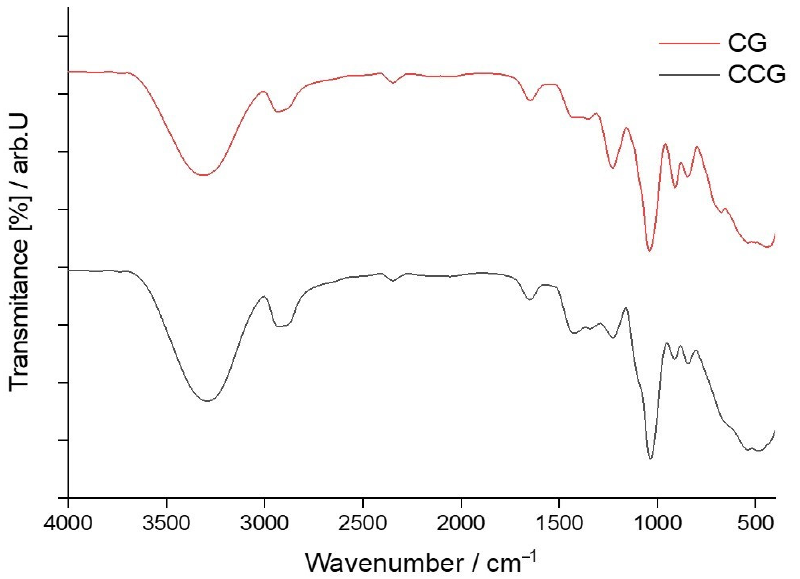
Figure 3. Superposed FTIR spectra of control membranes, CG and CCG.